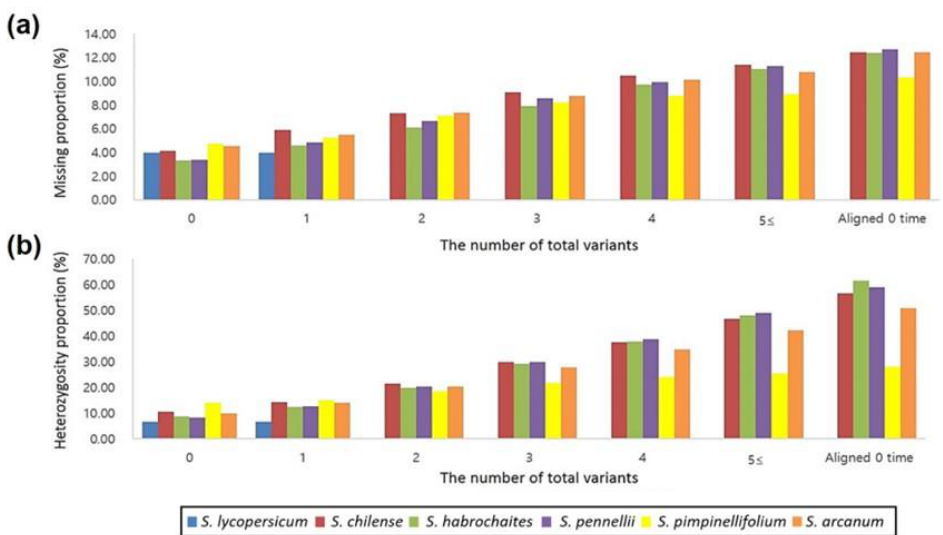
Figure 3. ( a ) The relationship between the proportion of failed (missing) or heterozygous; ( b ) SNP genotype data and the homology of the Axiom ® Tomato Genotyping Array probe sequences and reference genome sequences in different tomato species. The probe sequences for the 51,214 SNP loci were compared to the reference genome assemblies, to calculate the number of sequence variants. Aligned 0 time on the horizontal axis indicates the condition under which the probe sequence could not align with the reference genome assembly.